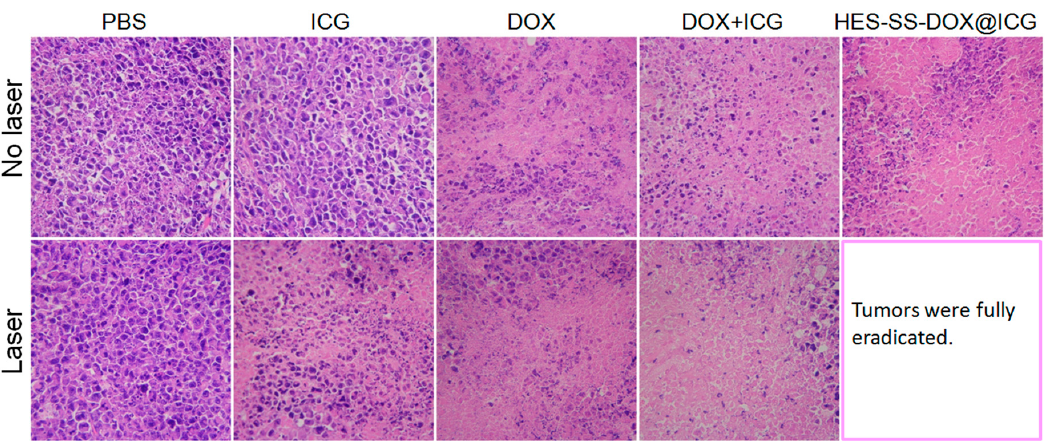
Figure 8. Representative optical micrographs of H/E-stained tissue sections, respectively, corresponding to tumors excised from H22-tumor-bearing mice treated with different agents (tumors were harvested after 14-day treatment, DOX equivalent, 8 mg/kg, ICG equivalent, 3.4 mg/kg, magnification, 200×).